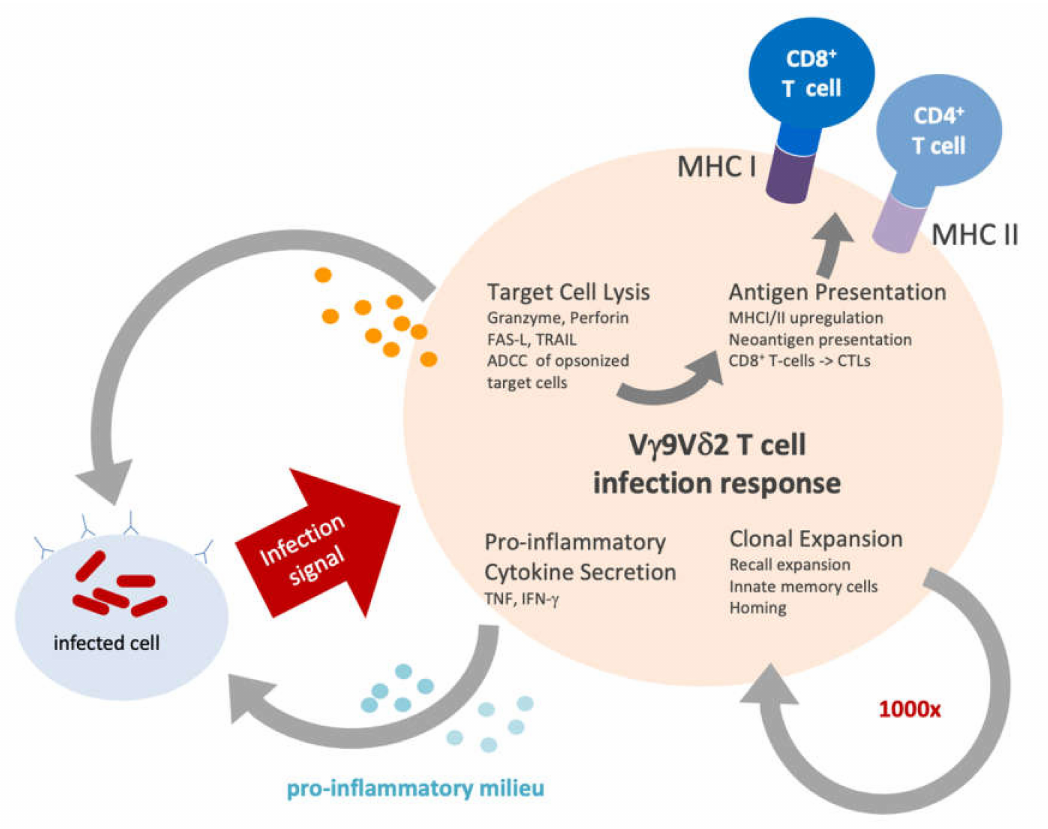
Figure 2. Immune functions of V γ 9V δ 2 T cells. An infection signal derived from an infected cell and mediated via BTN3A will induce a variety of cellular functions as follows:(i) lysis of the infected cell by cytotoxic mediators, such as granzymes, perforins or via the FS7-associated cell surface Antigen (Fas) / (CD95) and TRAIL-receptor induced cell death pathways; (ii) soluble material and opsonized, phagocytosed cellular material is digested and presented to TCR αβ + CD4 + and CD8 + T cells; (iii) a clonal expansion up to 1000-fold increase after stimulation with their selective antigens; (iv) stimulated γδ T cells release many di ff erent cytokines and chemokines, most importantly the pro-inflammatory molecules TNF- α and IFN- γ